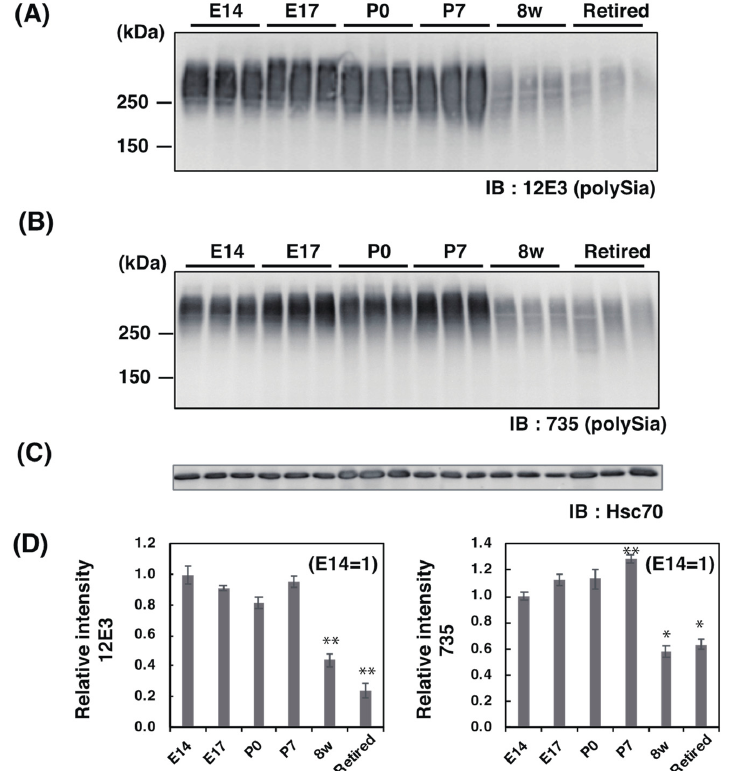
Figure 2. SDS–PAGE / Western blot analysis of polySia–NCAM derived from mouse brains at di ff erent developmental stages. PolySia expression at di ff erent brain development stages (E14, E17, P0, P7, 8 w, and retired, n = 3) was analyzed by SDS–PAGE / Western blotting. The brain homogenates were separated by SDS–PAGE (7% polyacrylamide gel) and blotted onto polyvinylidene difluoride (PVDF) membrane (10 µ g as protein / lane). The polySia–NCAM was visualized by anti-polySia antibodies, ( A ) 12E3, and ( B ) 735. An anti-HSC70 blot was also used as the control ( C ). ( D ) The left panel shows the relative intensity of immunostaining of the 12E3 antibody. The right panel shows the relative intensity of the 735 antibody. E14 staining was set to 1.0. * p < 0.05. ** p < 0.01.